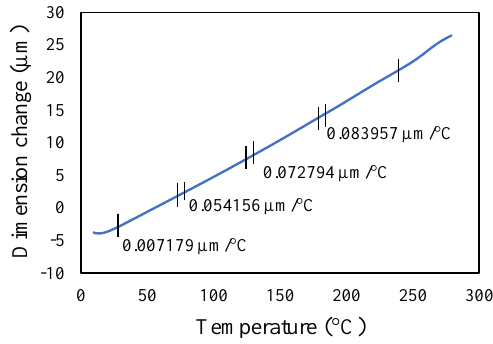
Figure 8. Thermal expansion of 0.5 mm crack depth specimen.